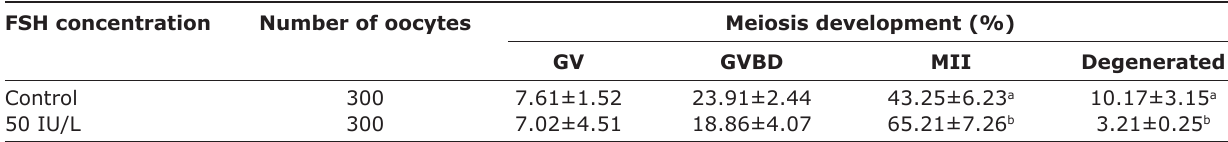
Table-1: Effect of FSH supplementation on Bligon goat oocyte maturation following 24 h of incubation and arceto orcein staining (%). FSH concentration